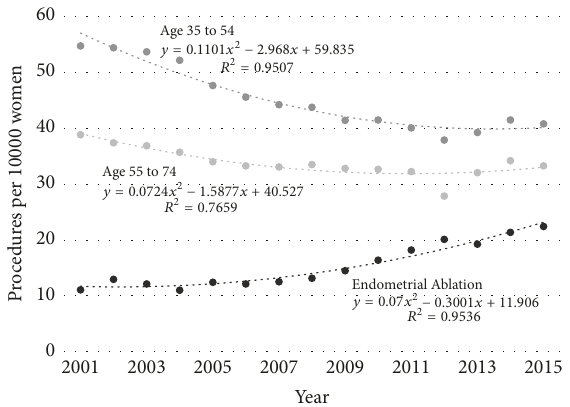
Figure 1: Age-stratified incidence rates of hysterectomy in Australia (procedures per 10000 women) for women aged 35–54 years and 55–74 years and incidence rate of endometrial ablation in women aged 35–54 years.